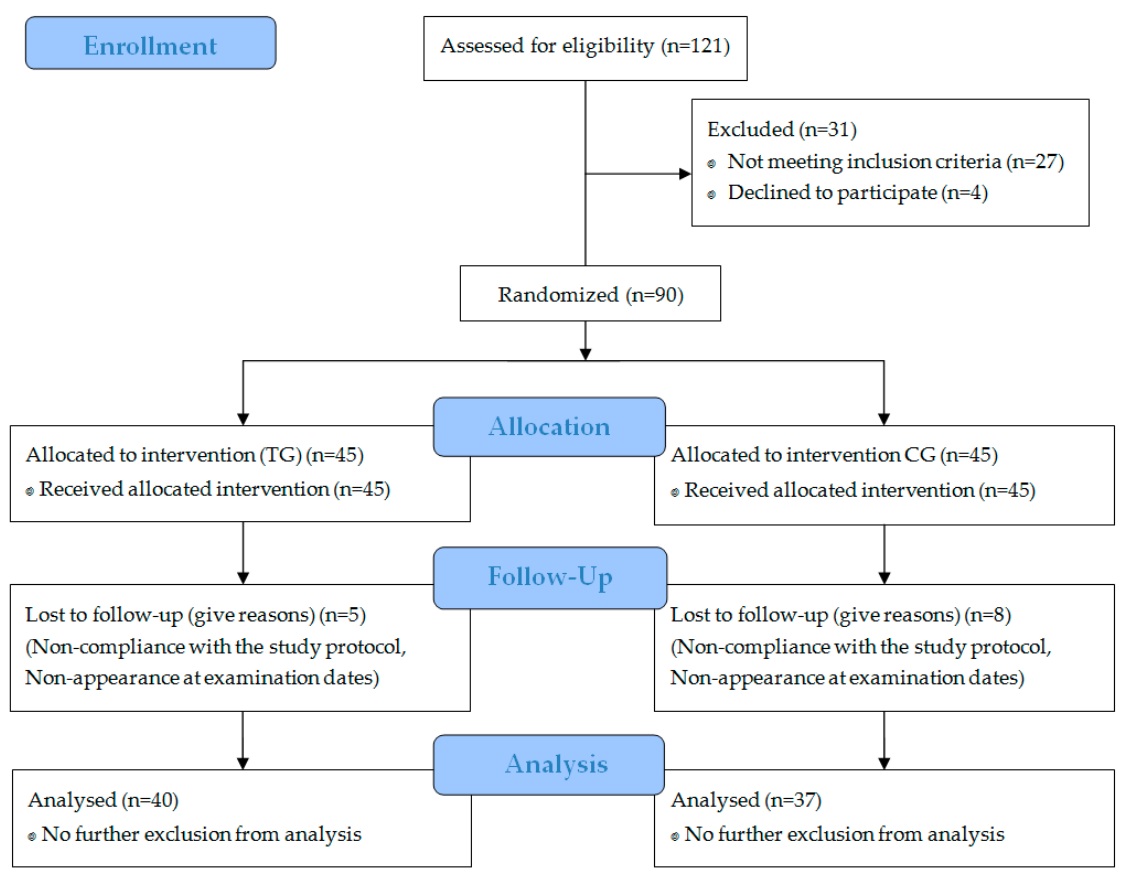
Figure 1. Flow diagram of subject’s recruitment, randomization, and follow up.